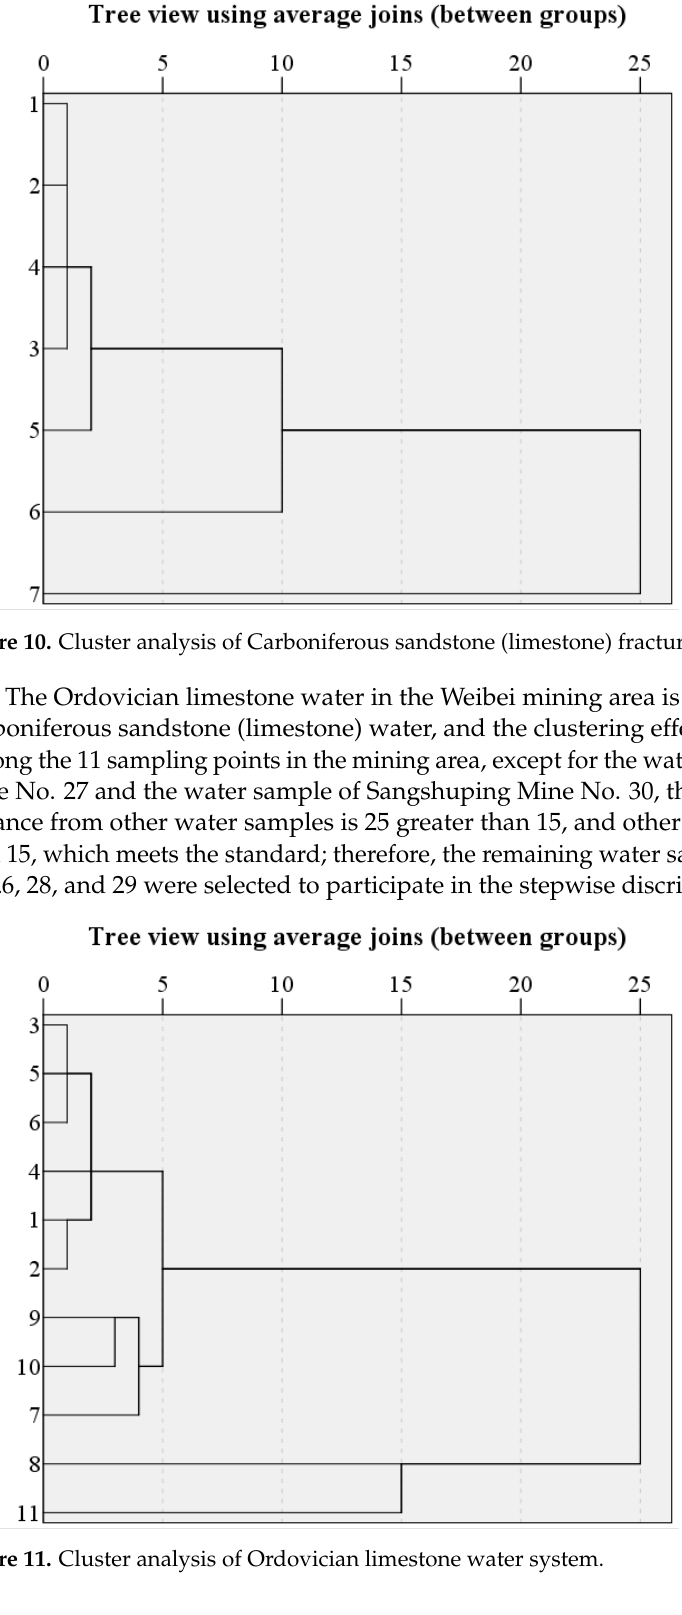
Figure 11. Cluster analysis of Ordovician limestone water system.